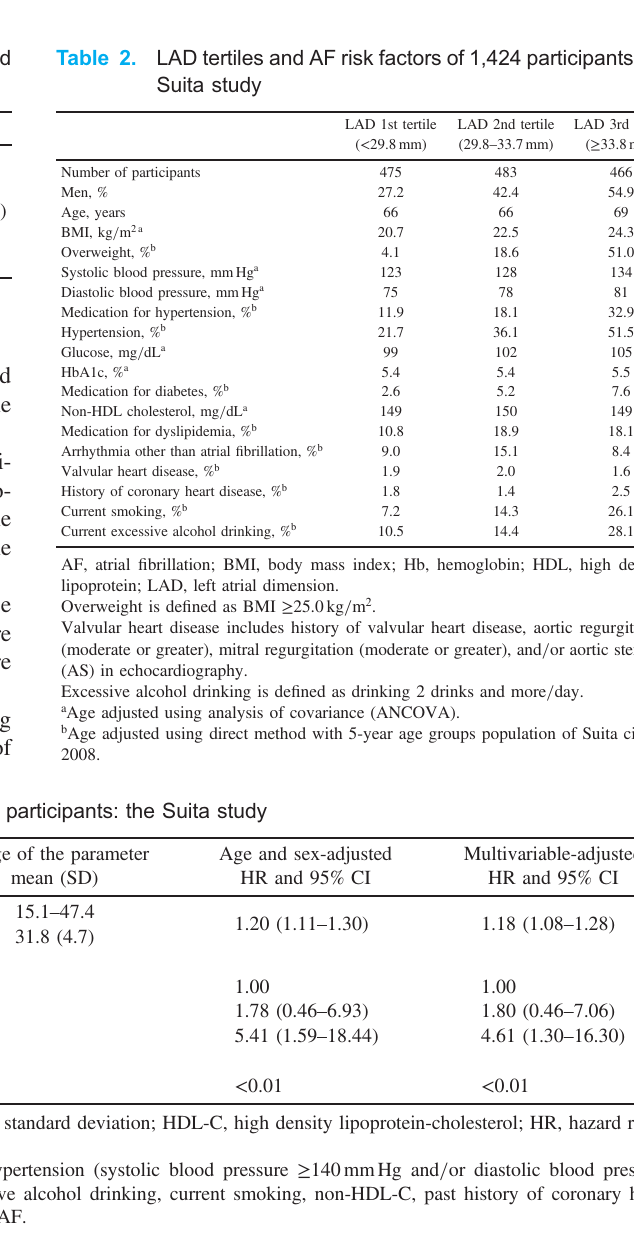
Table 4. Risk of 1-SD-increase of LAD and other parameters for the incidence of AF in 1,424 participants: the Suita study